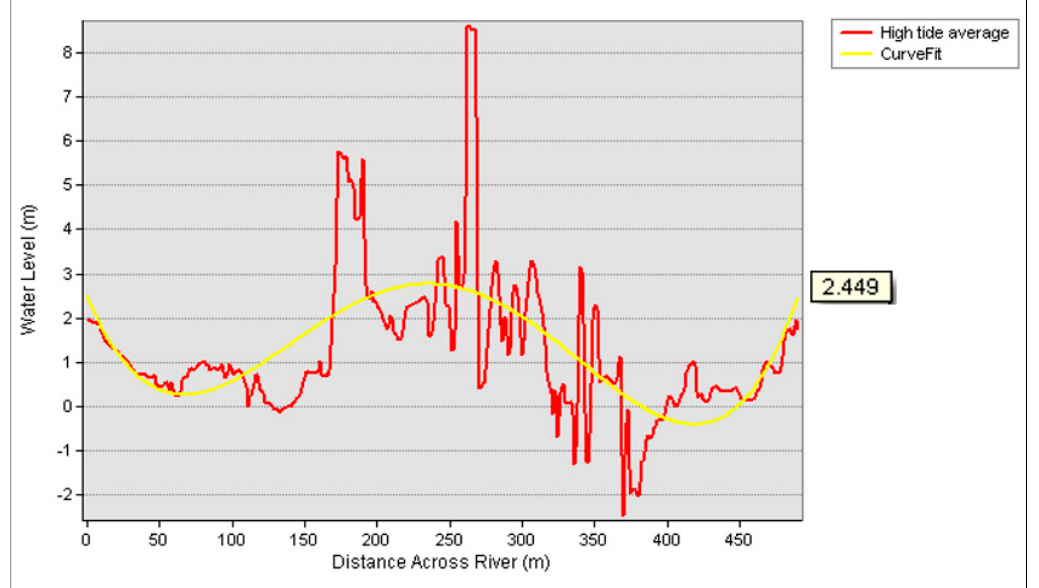
Figure 12. High tide average against tidal value at cross section 1.